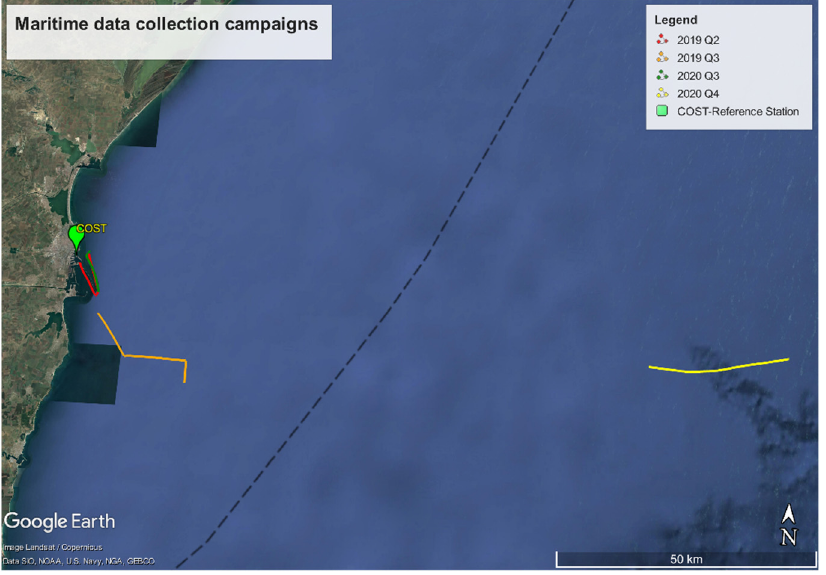
Figure 6. Trajectories of the maritime campaigns. Reference GNSS station is situated in the Port of Constanta on the Black Sea.